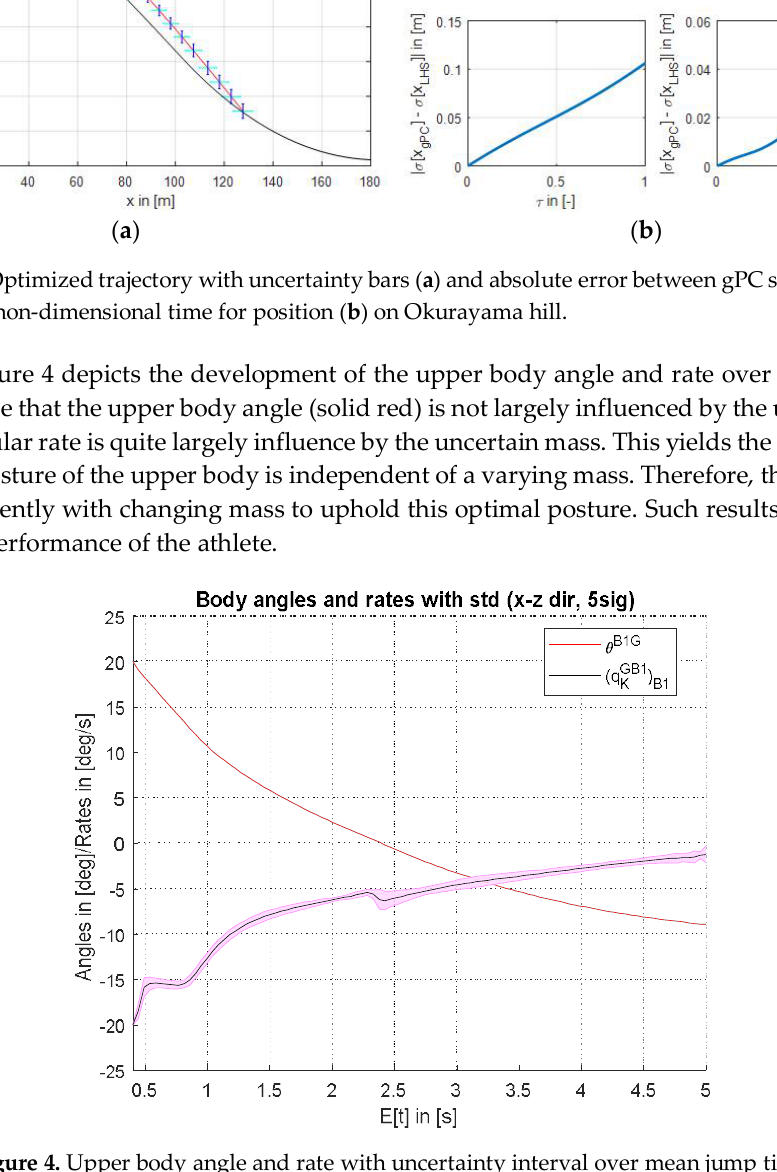
Figure 4. Upper body angle and rate with uncertainty interval over mean jump